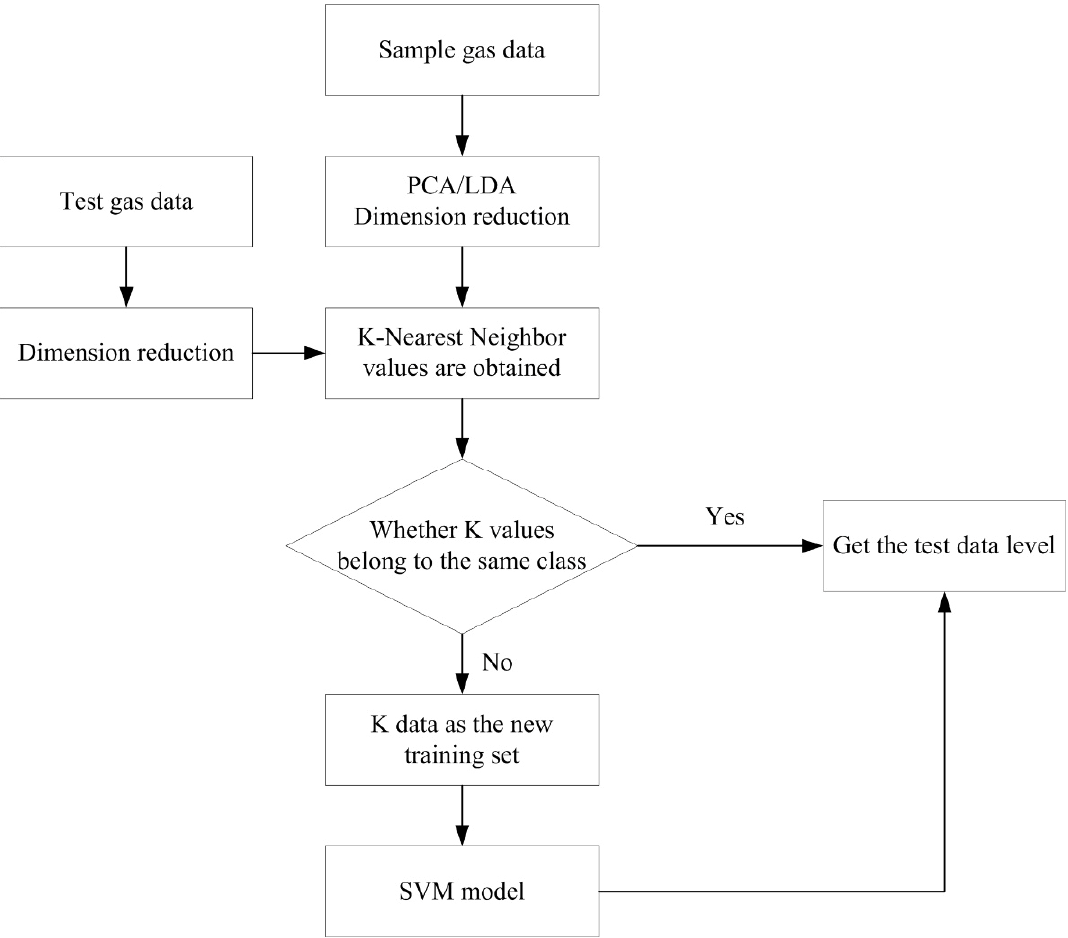
Figure 13. The process of the KNN-SVM algorithm.